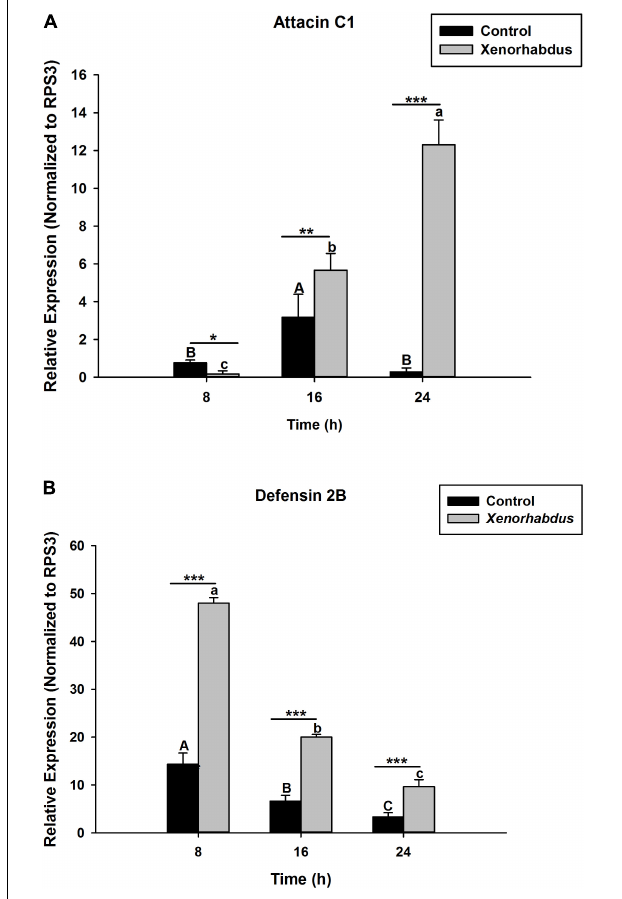
FIGURE 3 | Transcription of antimicrobial peptide (AMP) genes in O. nipae larvae injected with X . nematophila AMP transcription levels were shown for (A) Attacin C1, (B) Defensin 2B. Error bars labeled with different letters are significantly different (one-way ANOVA followed by LSD test, p < 0.05). ∗∗∗ P < 0.0001; ∗∗ P < 0.001; ∗ P < 0.01 indicates significantly different levels between the control and X . nematophila treatments at the indicated time period; while “ns” indicates no significant difference.